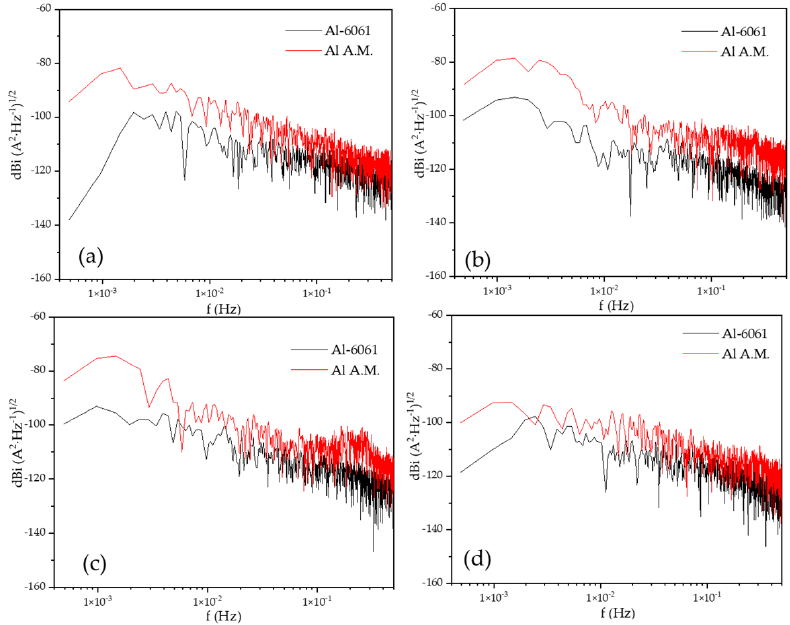
Figure 7. Power spectral density (PSD) in the current in H 2 O solution, ( a ) 0 h, ( b ) 24 h, ( c ) 48 h, and ( d ) 120 h. Table 6. Parameters obtained by PSD for the Al-A.M. alloy.